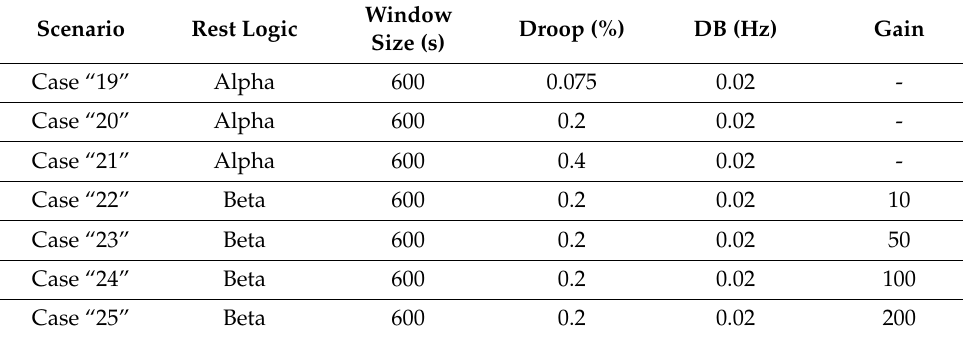
Table 2. A summary of the simulations with the SOC restoration